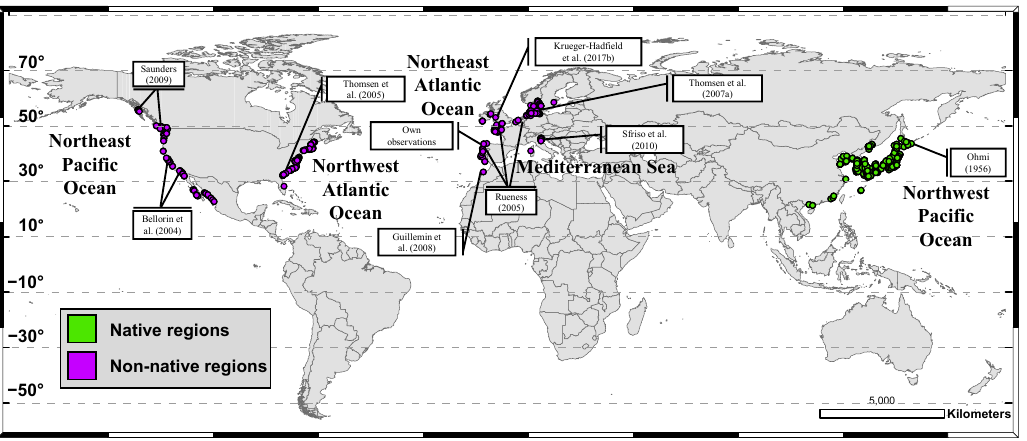
Figure 1. Map of the current distribution of Gracilaria vermiculophylla showing native (green points) and non-native populations (purple points). References noted in the map [16,28,37,38,65–69] represent the first records of G. vermiculophylla that were made outside its native area .